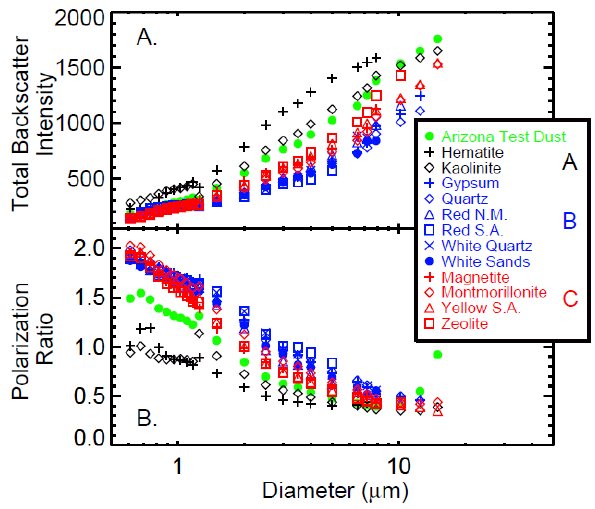
Fig. 5. Total backscatter intensity and polarization ratio as a func- tion of particle diameter for all dust types. Individual dust types identified as members of optical scattering Groups A, B, and C are represented by black, blue, and red symbols, respectively. Data for Arizona Test Dust, the one outlier in the study, is represented by green